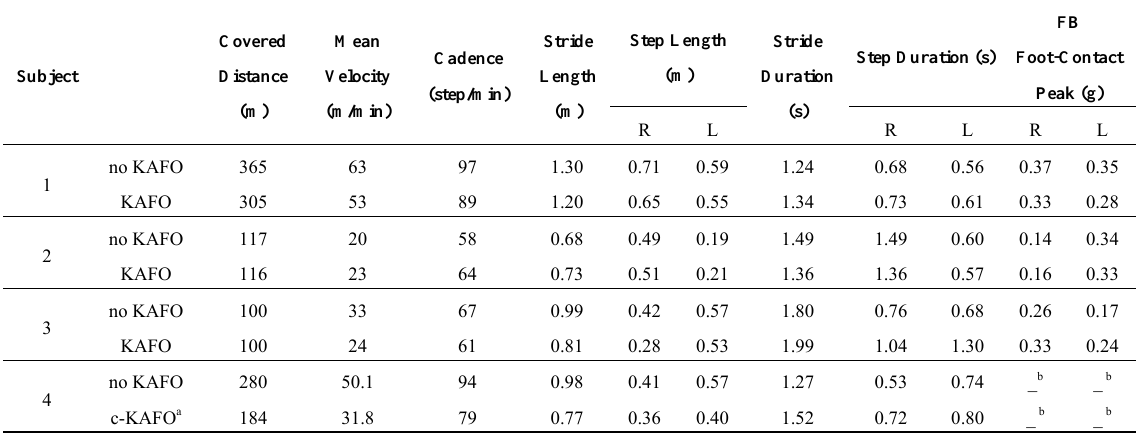
Table 2. Kinematic indexes measured during the monitoring trials through the 6MWT and the acceleration analysis (R = right, L =